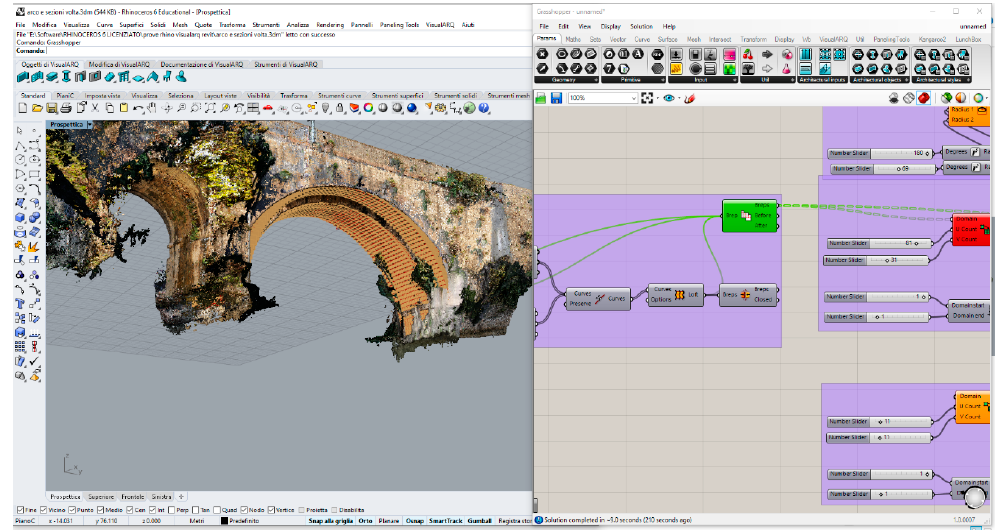
Figure 13. Three-dimensional model of the masonry bridge using Grasshopper software.